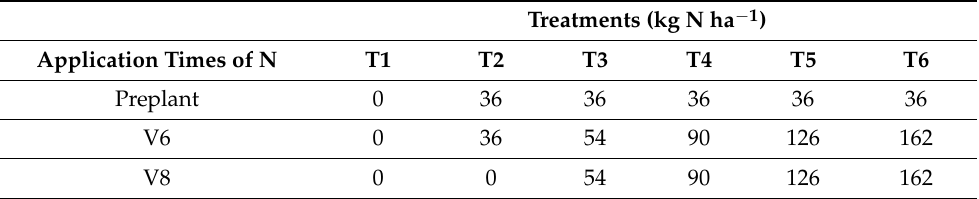
Table 3. Treatment layout of N application timing and rate of six experiments (2014 and